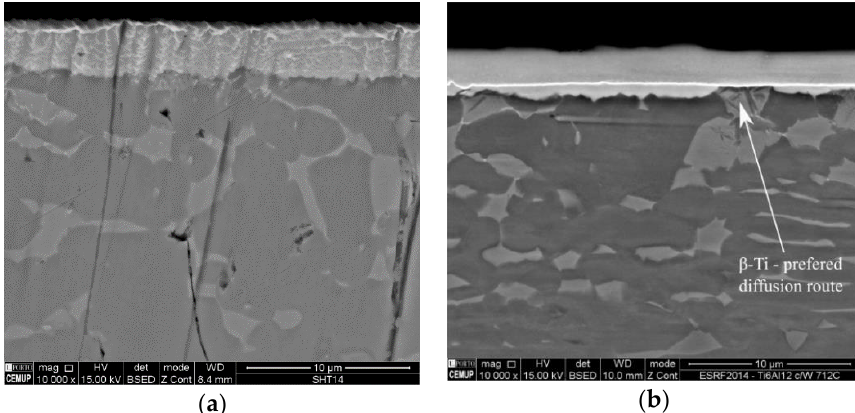
Figure 4. Cross-section SEM BSE images of Ni/Ti multilayer thin films with 12 nm period ( a ) without or ( b ) with W interlayer after HT at 850 °C.